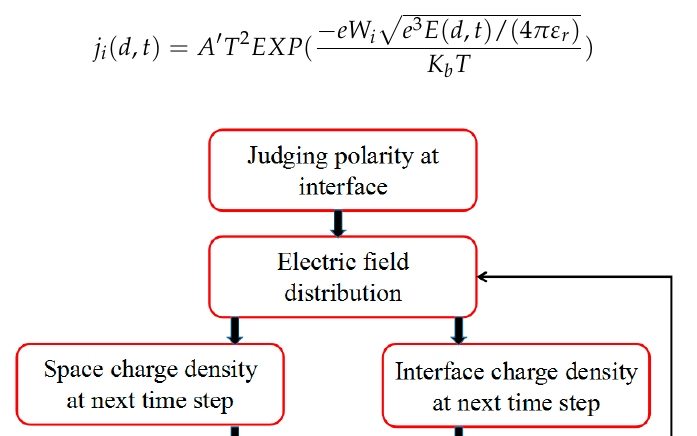
Figure 2. Flow chart for space/interface charge movement simulation. Table 1. Parameters for simulation.